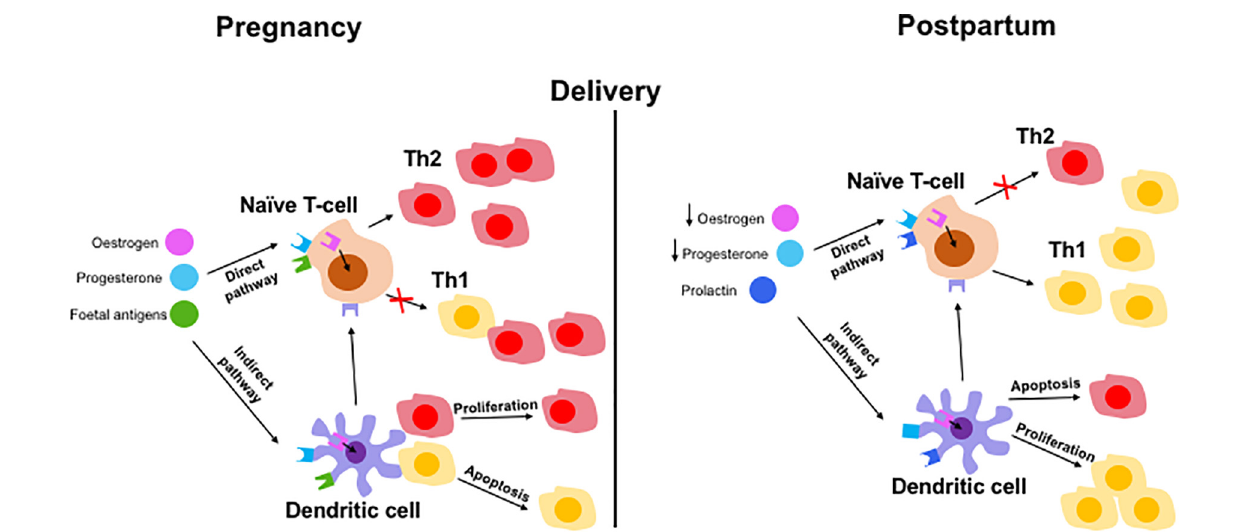
FIGURE 4 | Hypothetical mechanisms of immune tolerance in pregnancy and immunological escape at post-partum in AIH patient. Maintaining tolerance to the fetus by the mother via adaptive immune cells involving both direct and indirect pathways. Direct pathways include pregnancy hormones and fetal antigens presenting to naïve T cells which results in a Th2 predominance phenotype during pregnancy. Lack of hormones and fetus results in switching back to Th1 dominant immune balance. Indirect pathway involve hormones and fetal antigen priming to naïve cells via antigen presenting dendritic cells resulting in Th2 cells proliferation and Th1 cells apoptosis (in pregnancy) and reverse effect during post-partum